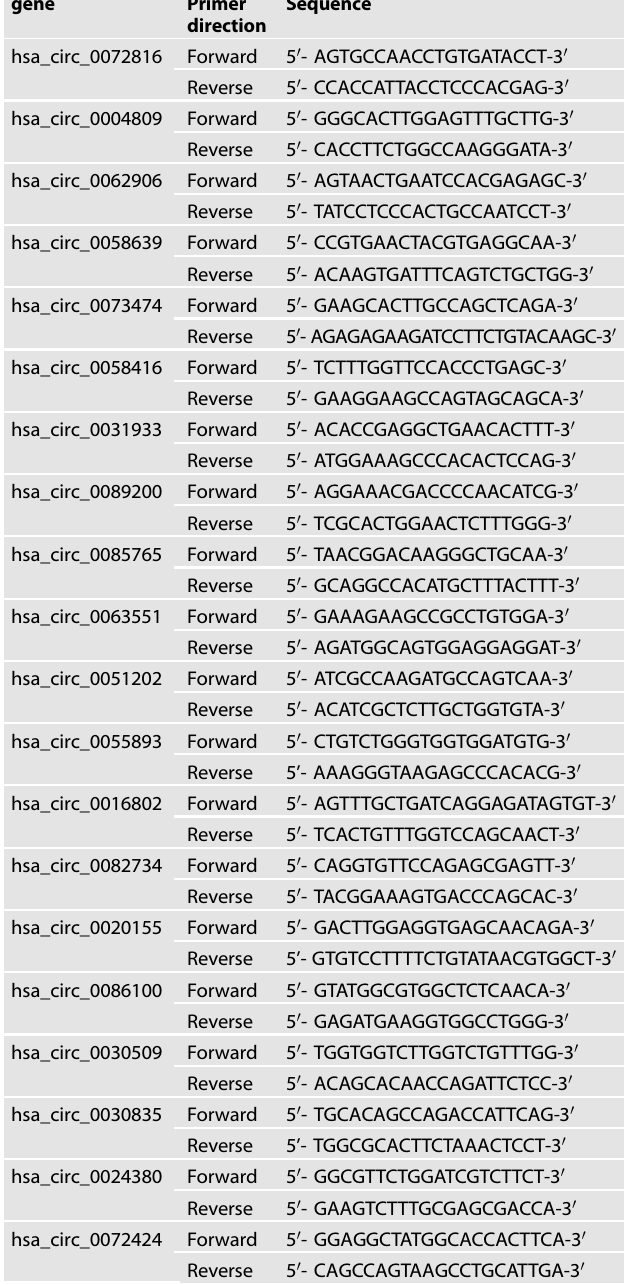
Table 1. The sequence for the circRNA